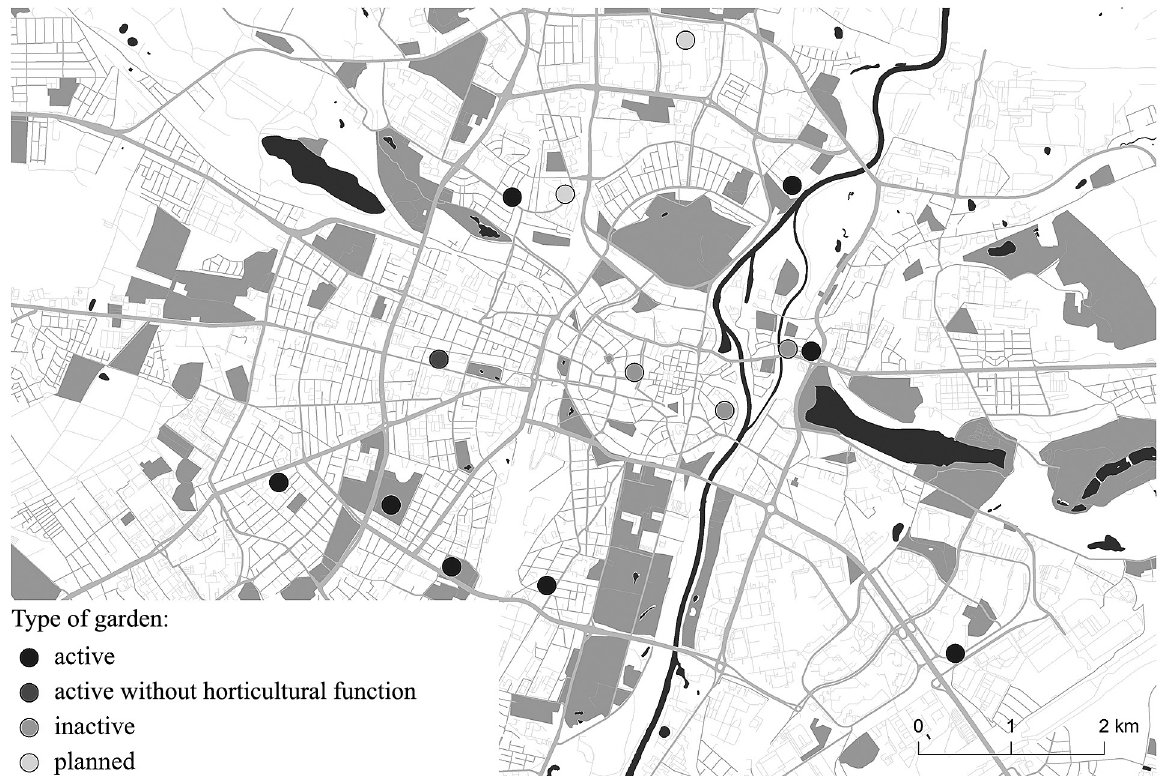
Fig. 4. Distribution of community gardens in